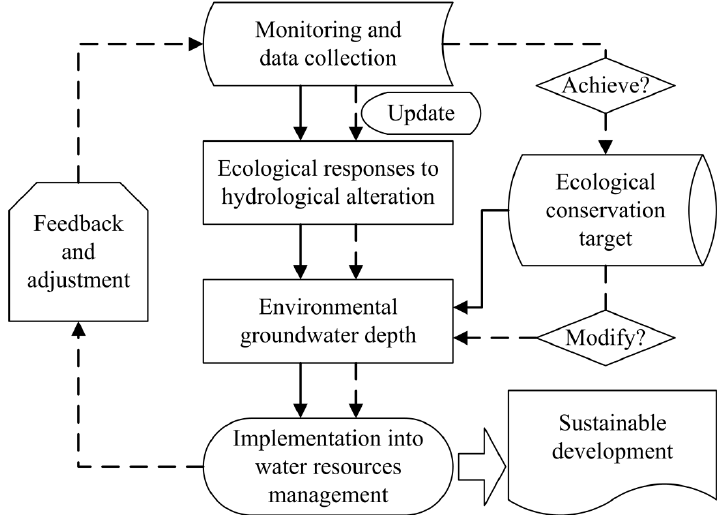
Figure 2. A conceptual framework for designing environmental groundwater depth. Note: solid lines indicate the preliminary processes and dashed lines denote the follow-up feedback processes.